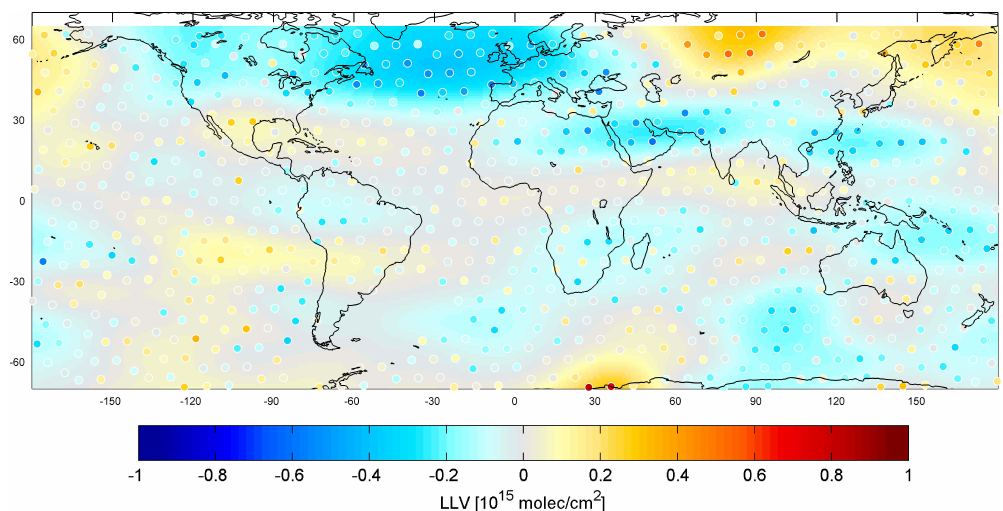
Fig. 4. Longitudinal Limb Variation (LLV) 1L for 28 January 2006. Disks show the LLV for the individual limb states ( 1L ), the map shows the interpolated and smoothed field d 1L(d,3,8)